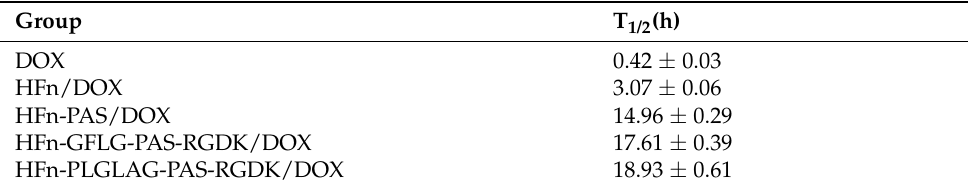
Figure 5. Plasma concentrations of protein/DOX and free DOX in Sprague Dawley rats of different groups. Data were expressed as mean ± SD ( n = 3). Table 3. Half-life of each protein/DOX in Sprague Dawley rats ( n =